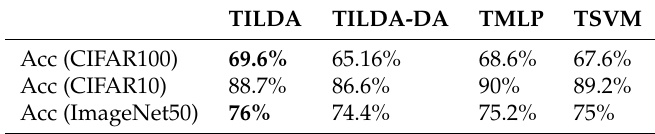
Table 3. Comparison of TILDA with non-incremental learning methods. TILDA